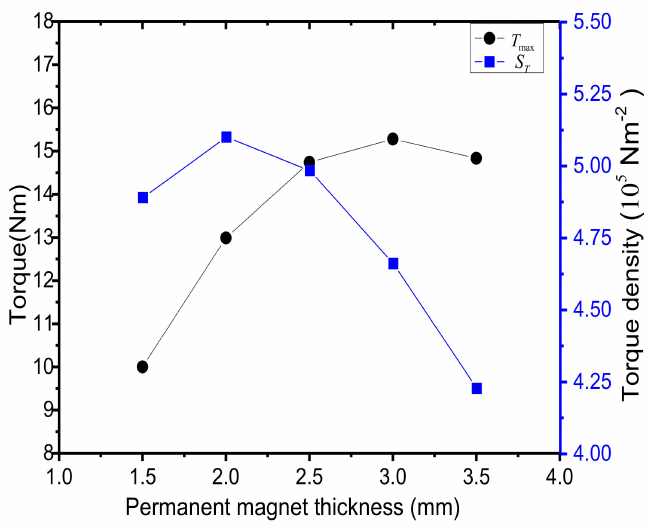
Figure 14. T max and S T versus permanent magnet